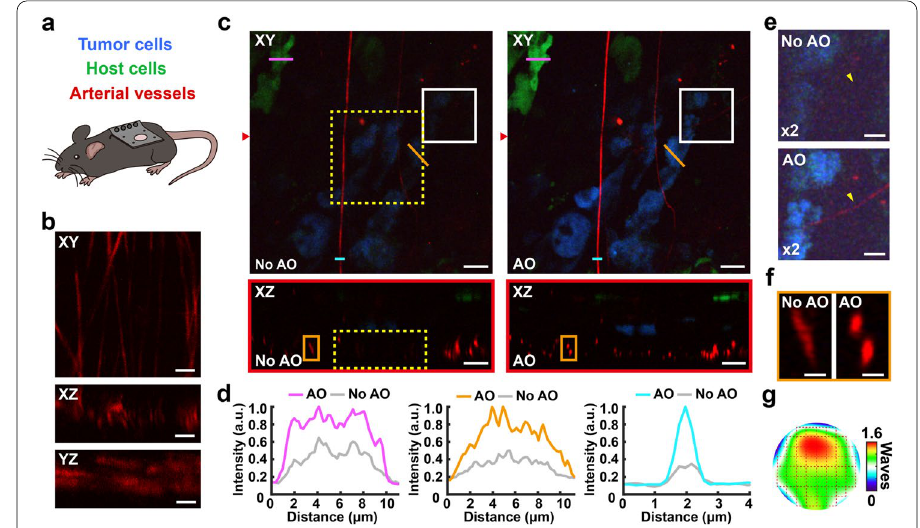
Fig. 4 AO improves three-color intravital imaging of a tumor microenvironment. a The tumor microenvironment was imaged through a dorsal skin-fold window chamber. The tumor cells, host cells and arterial vessels were labeled with mCerulean, EGFP and Alexa Fluor 633, respectively. b Maximum intensity projection of the microvessels centered 92 μm below the tissue surface, with which the aberration was measured. c Maximum intensity projection (XY) of the image volume 76–81 μm below the tissue surface, and image of the axial section (XZ) indicated by the red arrowheads without and with AO correction. The yellow dashed boxes indicate the positions of the microvessels used for aberration measurement. d Intensity profiles along the pink, orange and cyan lines in ( c ). e Zoomed-in views of the white boxes in ( c ). The images are enhanced with a 2x digital gain to increase the visibility. The yellow arrowhead indicates a microvessel. f Zoomed-in views of the orange boxes in ( c ). g Corrective wavefront. The dashed squares indicate the layout of the wavefront segments, where each wavefront segment corresponds to a unit square. A 2 stepped overlapping mask approach was used in the measurement process. Scale bars, 5 μm in ( b ), 10 μm in ( c ), 4 μm in ( e ), and 2 μm in ( f